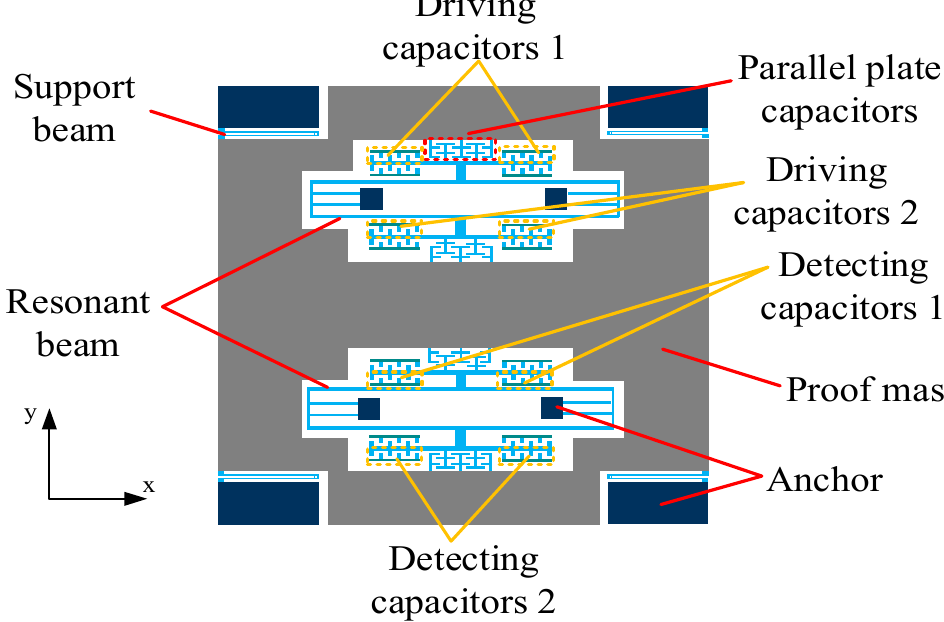
Figure 1. Schematic diagram of the overall structure of the accelerometer.